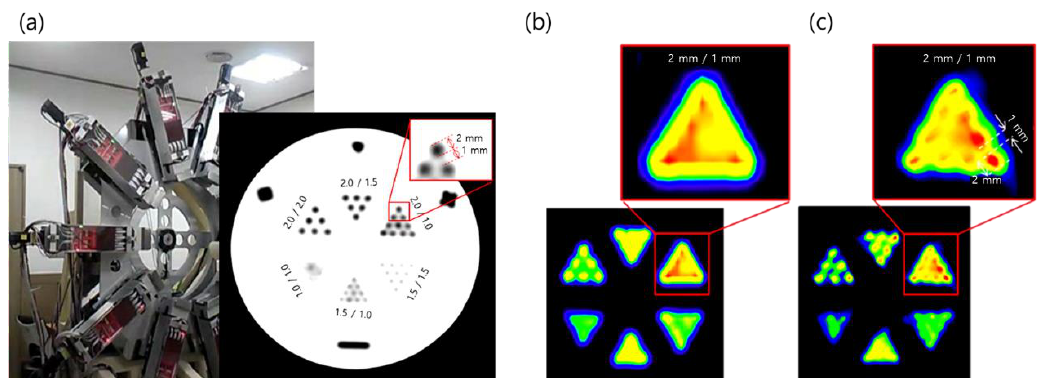
Figure 3. ( a ) Prototype high-resolution wobbling and zooming PET system developed by our group. ( b ) Images of the spatial phantom obtained via HRRT-PET and ( c ) by the prototype wobble-PET system. Reprinted with permission from Cho et al., 2019, IEEE [34].